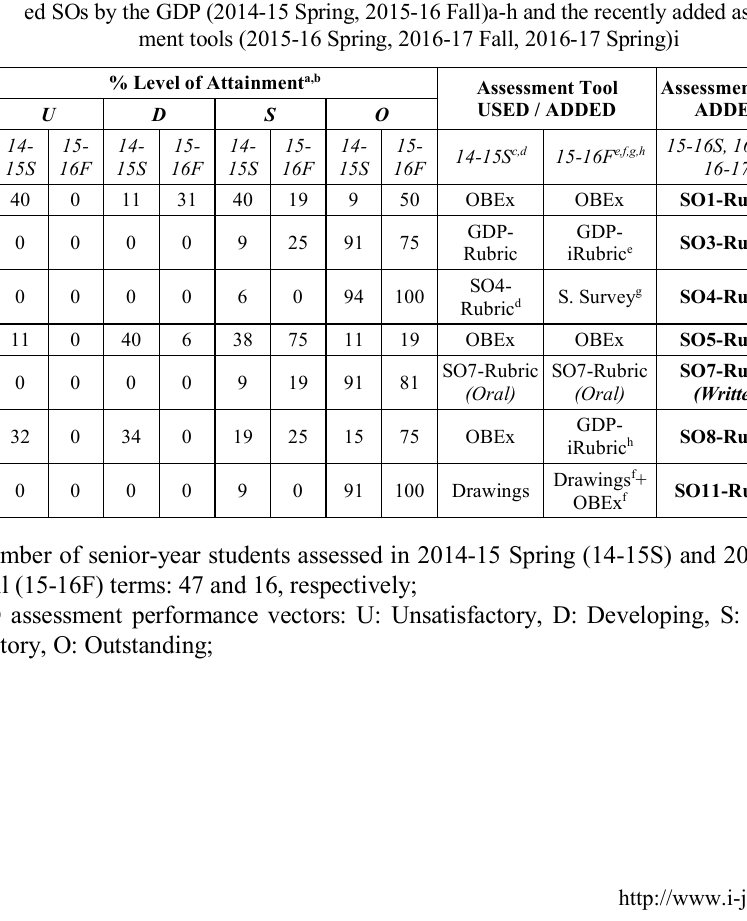
Assessment Tool USED / ADDED ADDED i U